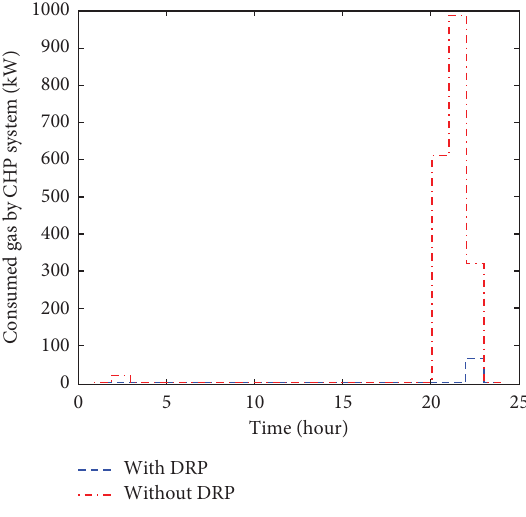
Figure 15: Te gas consumed by